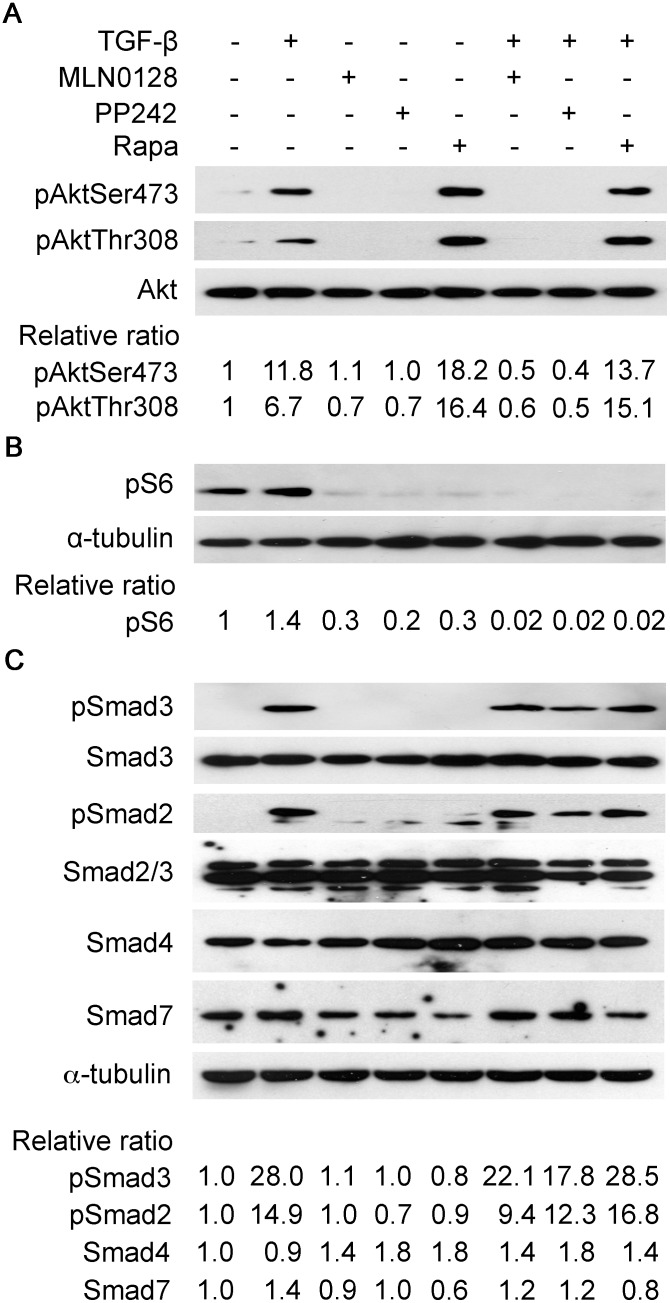
Effect of mTOR inhibitors on TGF-β activation of mTOR and Smad pathways.Serum-deprived IPF fibroblasts were treated with TGF-β for 60 minutes or left untreated in (A), followed by Western blot analysis with anti-phospho Akt (Ser473 or Thr 308) and anti-total Akt antibodies, or in (B) for 6 hours in the presence or absence of indicated inhibitors MLN0128 (0.2 µM), PP242 (2 µM), or rapamycin (0.02 µM), followed by Western blot analysis with anti-phospho-S6 and anti-α-tubulin antibodies. (C) Serum-deprived IPF fibroblasts were treated with or without TGF-β for 15 minutes in the presence or absence of indicated inhibitors followed by Western blot analysis with an anti-phospho-Smad2 or Smad3 antibody. Expression of total Smad-2, 3, 4 and 7 was analyzed by Western blot. Experiment was done on three lines, which are shown in Figure 1; results were similar between the three lines and results from the IPF fibroblasts isolated from surgical lung biopsy are shown here.